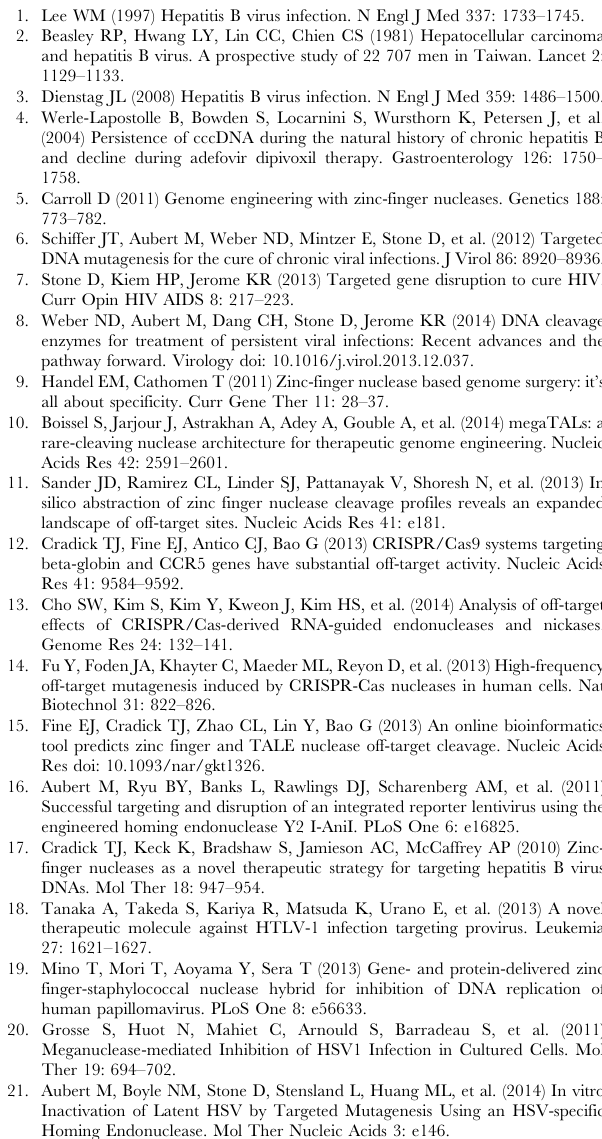
nucleotides show variations contained in the HepAD38 HBV genome that are different from the designed ZFN